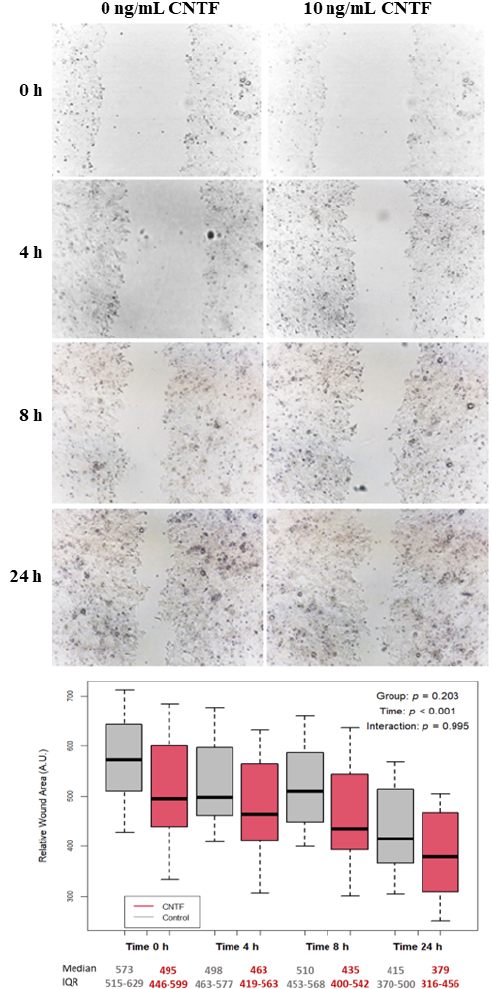
Figure 5. Wound healing assay after treatment with rhCNTF in 22Rv1 cell line. Representative photos of wound areas are shown; no significant difference in wound closure was found in cells treated with 10 ng/mL CNTF compared to untreated controls. Results are expressed in arbitrary units (A.U.) and reported as boxplots.